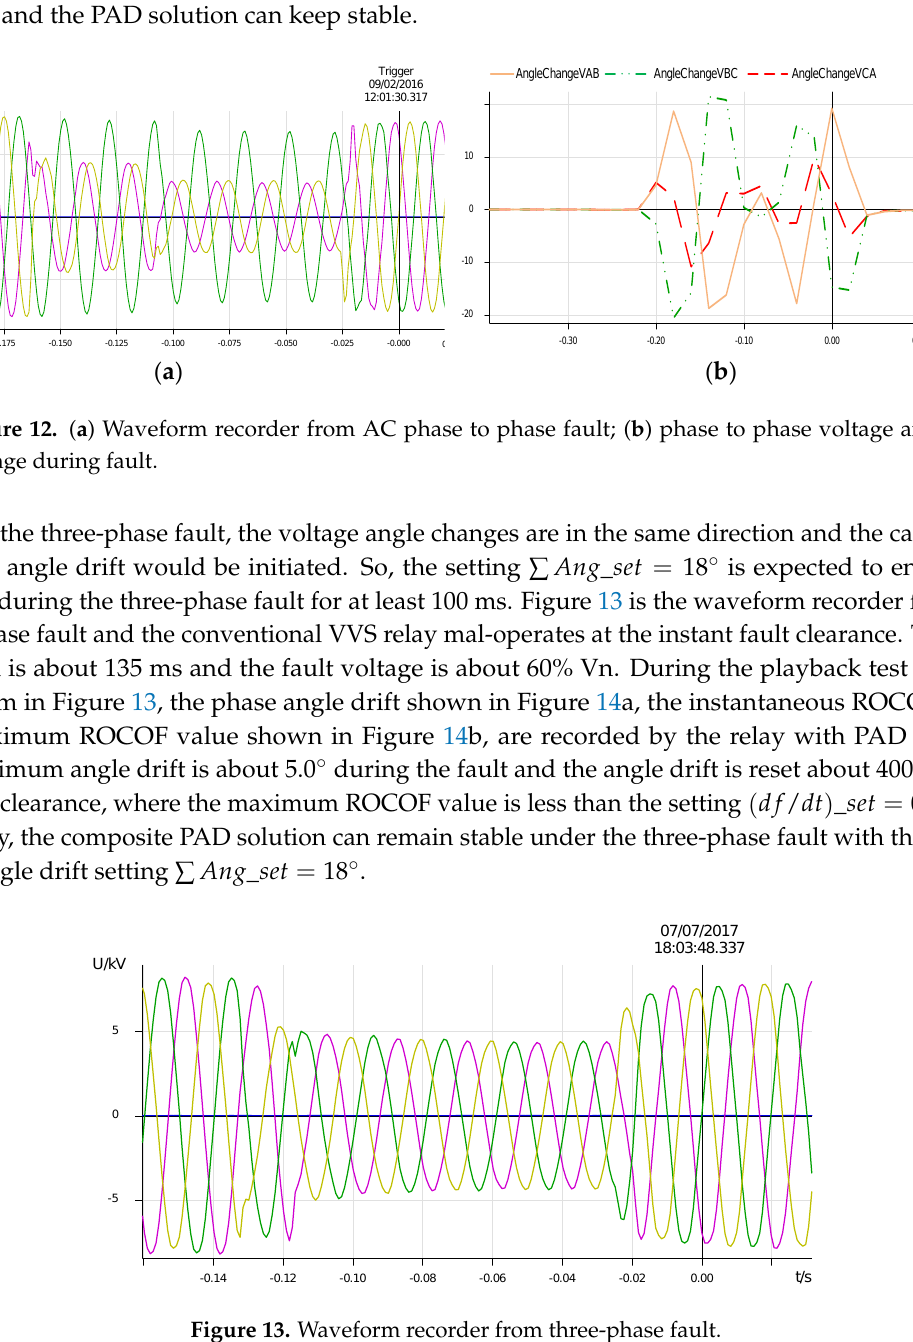
( b ) Figure 14. ( a ) Phase angle drift; ( b ) maximum and instantaneous ROCOF values during the three- phase fault. For other waveform recorders, this composite PAD solution can also work correctly. It can detect the islanding condition and remain stable under system fault. It is a pity there is no waveform recorder from the system frequency fluctuation condition. Hence, to fully estimate the performance and to get the setting configuration guide for this composite PAD solution, more field tests are necessary. 7. Conclusions The VVS relay and ROCOF relay are widely applied to detect the islanding condition. However, the performances of both VVS relay and ROCOF relay are not good. There are inherent non-detection zones and mal-operations are also possible. The proposed composite islanding detection solution in this paper applies both VVS and ROCOF features of the islanding condition. It detects the VVS in the same direction to initiate the calculation of accumulated phase angle drift. It monitors the real-time ROCOF to reset the calculations. The operation criterion is not directly based on VVS or ROCOF, but only based on the accumulated phase angle drift. So more sensitive settings for VVS and ROCOF function can be applied, which can reduce the ratio of NDZ. Significantly, the balanced three phase voltage vector shifts are applied to distinguish the islanding condition from the unbalanced system fault. For three-phase fault, this proposed islanding detection solution can remain stable dependent on the proper angle drift setting. This composite islanding detection solution is verified in Matlab Simscape physical simulation based on the synchronous machine and the practical waveform recorded from different sites. The results show this composite islanding detection solution is stable under the system fault and sensitive for the islanding condition where the power imbalance is more than 10%. The next step of this research is to perform the field tests in as many as possible different countries.